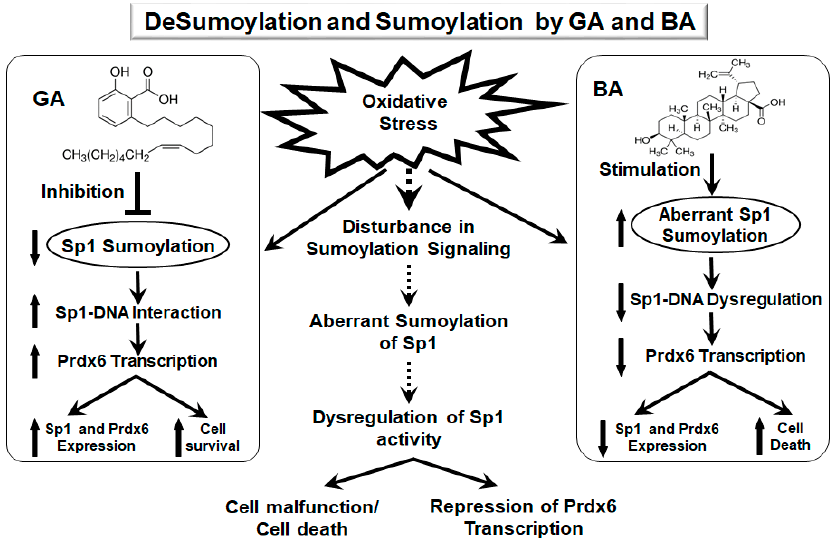
Figure 12. Diagrammatic illustration showing plausible mode of action of GA and BA in modulation of Sp1 and its targeted gene Prdx6 and in determining LECs fate. Oxidative stress-evoked aberrant Sumoylation signaling causing dysregulation of Sp1 activity and Prdx6 in LECs can be blunted by GA application. GA enhances Sp1 transcriptional activity by enhancing its cellular stability through inhibiting its aberrant Sumoylation.